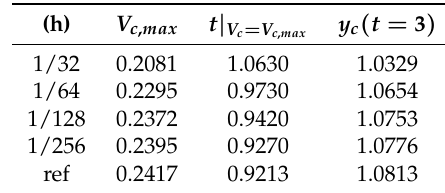
Table 2. Benchmark quantities: Maximum rise velocity V c , max with corresponding time t | V